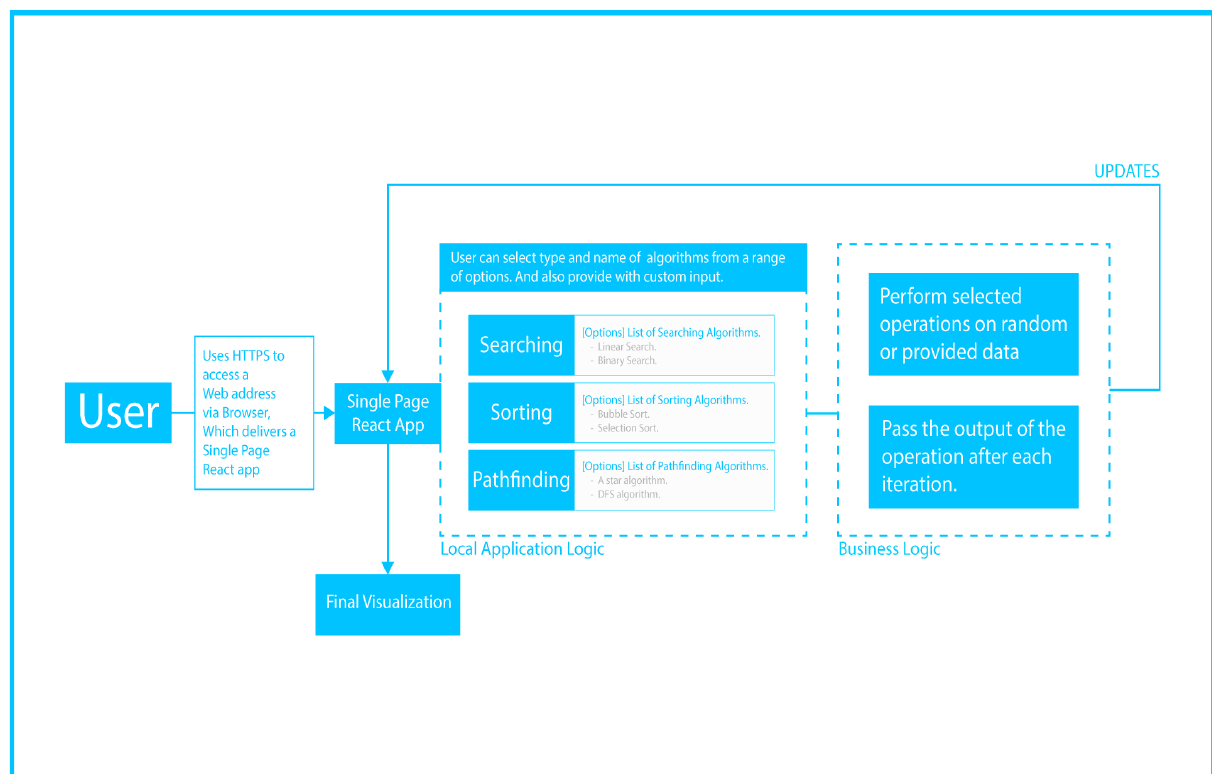
Fig.1. Algovis: A System